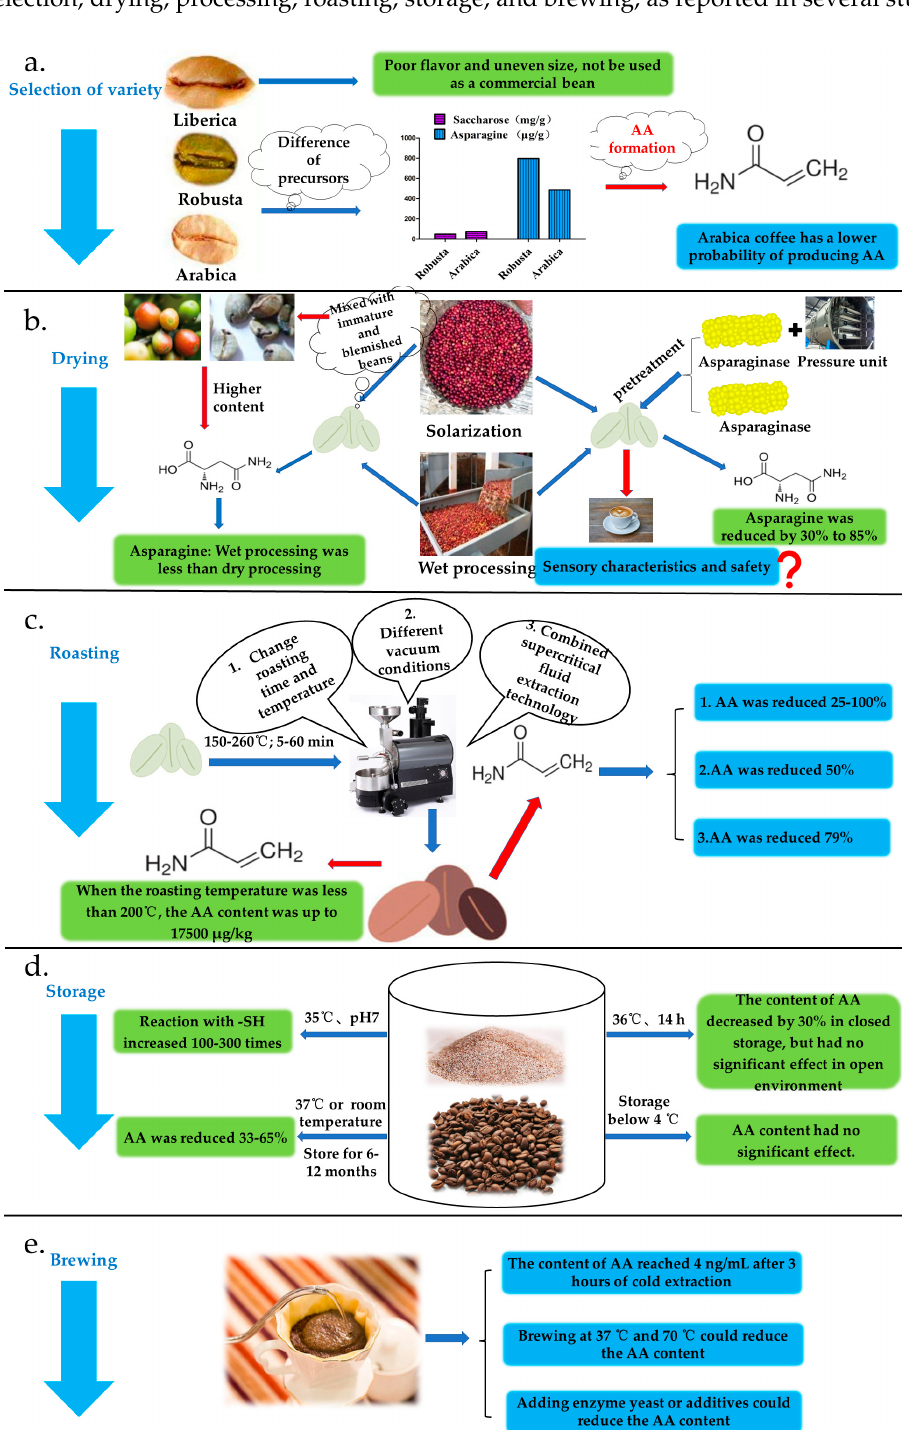
Figure 3. A review of studies investigating acrylamide inhibition during coffee processing. ( a ) Selection of variety; ( b ) Drying process stage; ( c ) Roasting stage; ( d ) Storage stage; ( e ) Brewing stage.